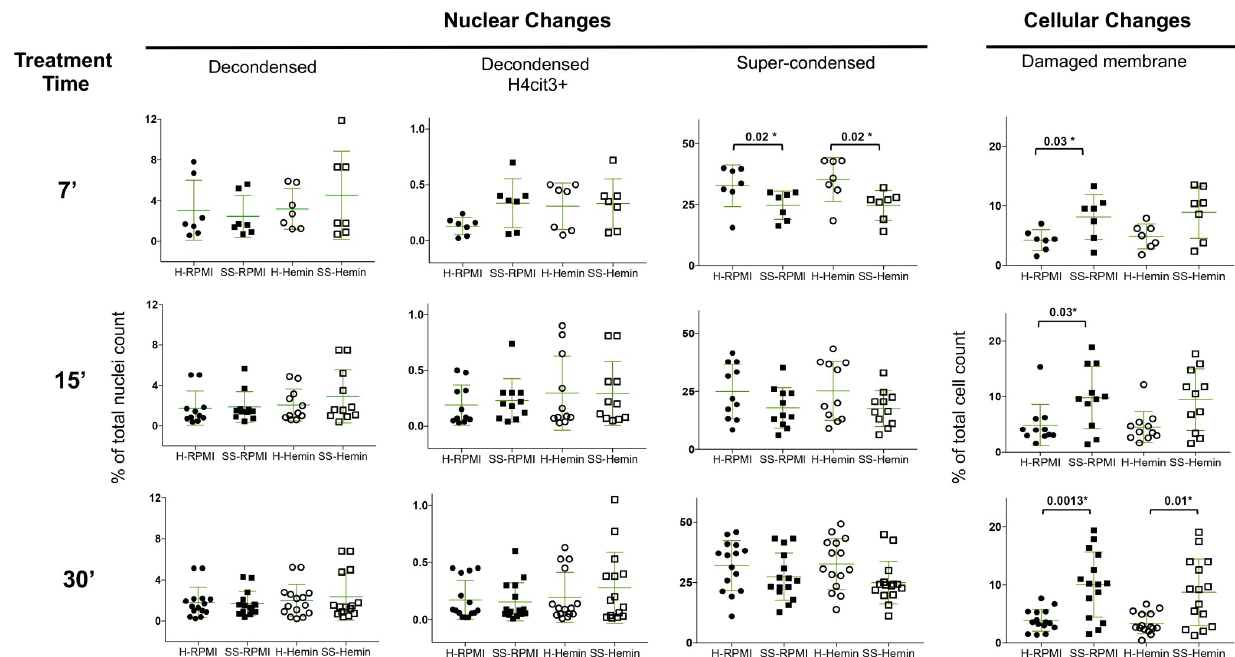
Fig 1. NETs-related nuclear and cellular changes occur in neutrophils from SCD patients in the absence of a NETs-specific stimulus and in the presence of hemin. Purified neutrophils from healthy donors (H) or SCD patients in steady-state (SS) were left untreated in RPMI or treated with 20 μ M hemin for the specified times (7, 15 or 30 minutes). Stimulation was stopped with PFA and the fixed cells were stained for CD66b, H4cit3, MPO and DNA. Specific nuclear changes related with NETosis (nuclear decondensation in the presence or absence of histone H4 citrullination) or apoptosis (nuclear super-condensation), as well as cell membrane damage were assessed using imaging flow cytometry. Variable number of experimental repeats were conducted for each time point (7 minutes: N = 7: 15 minutes: N = 11; 30 minutes: N = 15). Data presented as dot plots ± S.D., significance calculated with Mann-Whitney test. Note that SS refers to steady-state, and not the SCD genotype SS.